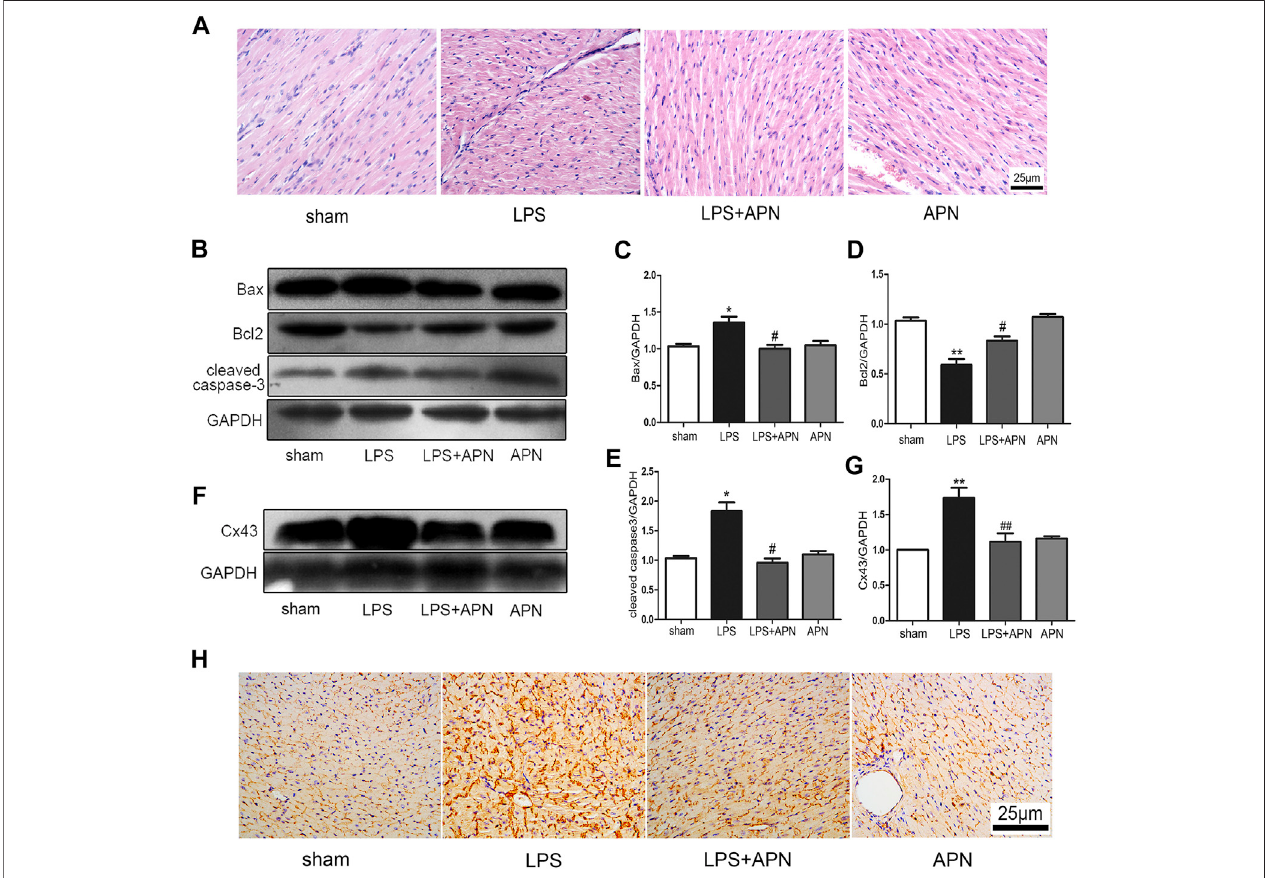
FIGURE 5 | The effects of APN on sepsis-induced myocardial injury. (A) HE staining of myocardial tissue at 400 × . (B) Bcl2 was downregulated and Bax and cleaved caspase-3 were upregulated in myocardial tissues of septic mice, but these effects were attenuated by APN. (C – E) Quanti fi cation of Bax, Bcl2, and cleaved caspase-3 expression. (F) Cx43 was upregulated in myocardial tissue of septic mice, and this effect was changed by APN. (G) Quanti fi cation of Cx43 expression. (H) Immunohistochemical staining showed the expression of Cx43 in myocardial tissue. Scale bar: 25 μ m. The brown immunostaining represents Cx43. (* p < 0.05, ** p < 0.01 vs. control; # p < 0.05, ## p < 0.01 vs. the LPS group. The data are shown as the means ± SEs (n (cid:2)